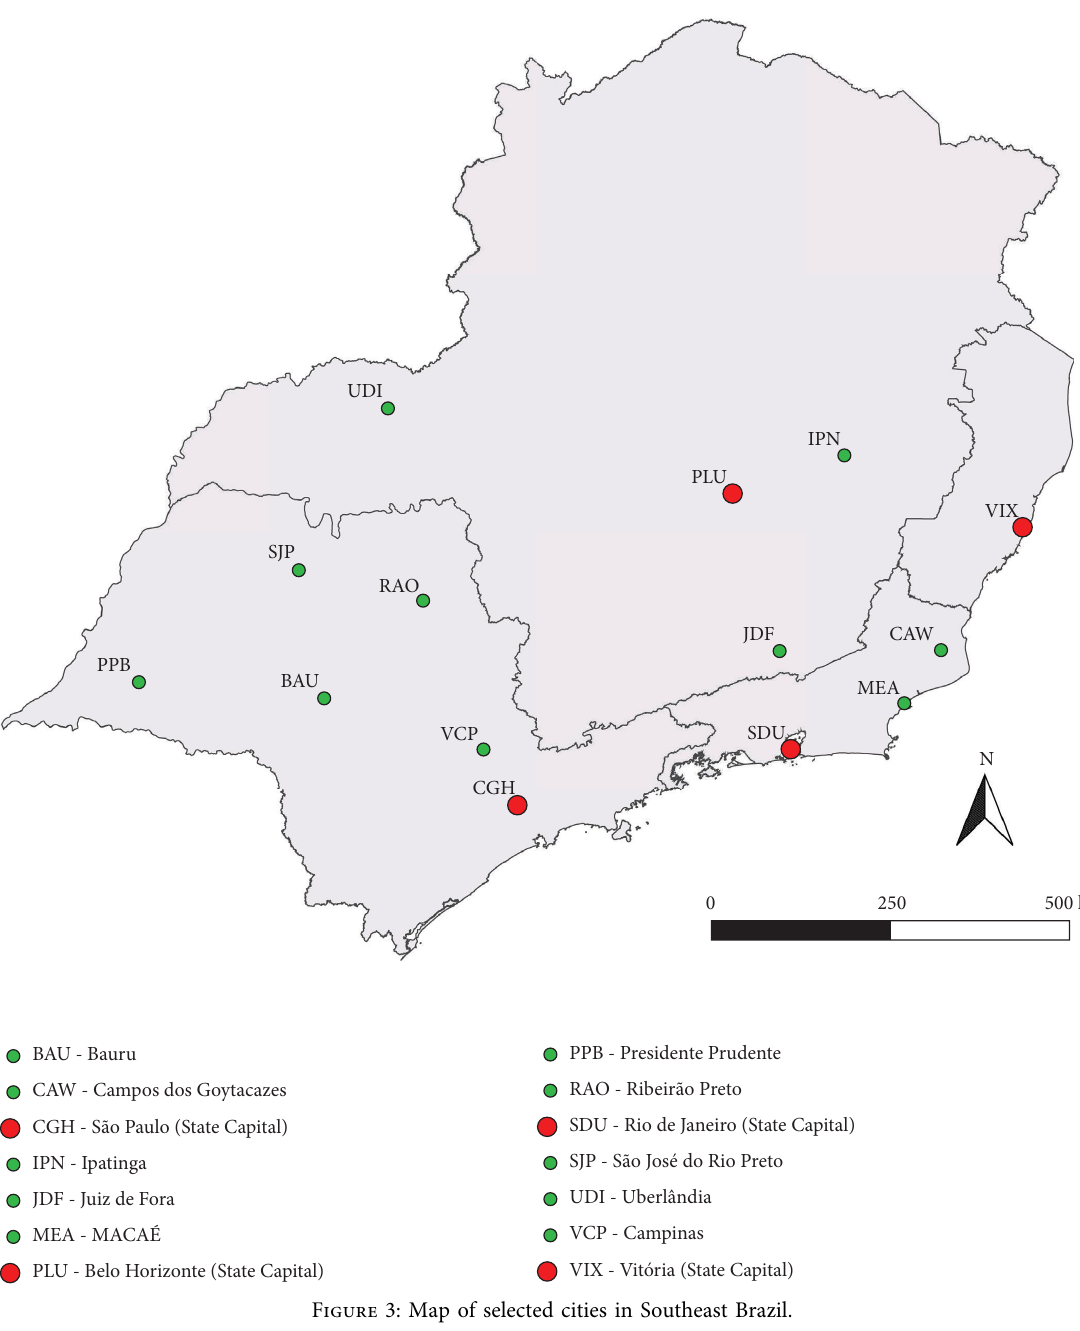
Figure 3: Map of selected cities in Southeast Brazil.